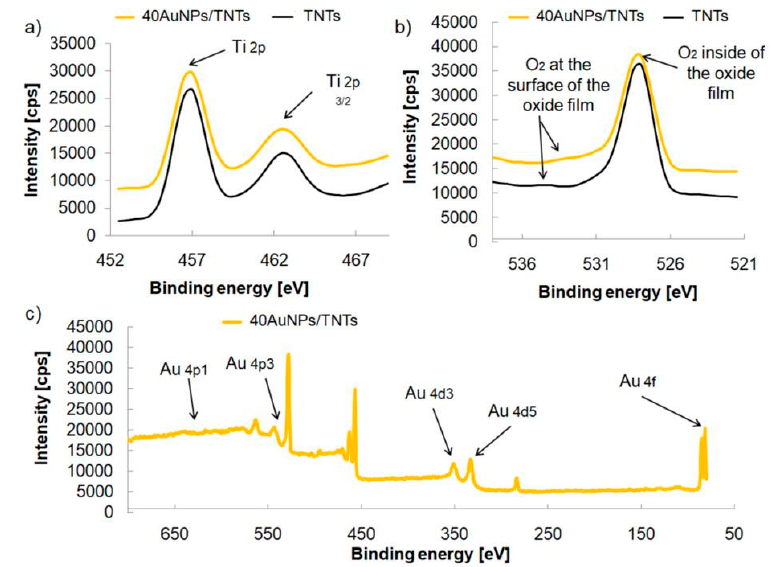
Figure 7. Chemical composition of the annealed TNTs (diameter 50 ± 5 nm, 1000 ± 100 nm thickness) before and after gold nanoparticles deposition measured with XPS: ( a ) Ti 2 p spectra, ( b ) O 1 s spectra ( c ) Au spectra.